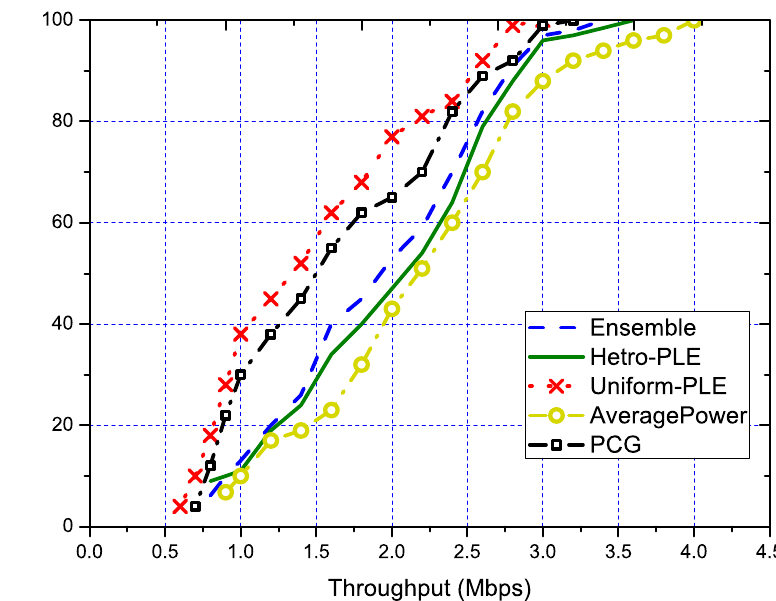
Figure 2. The CDF of throughput using different RSS estimation algorithms. PLE, Path Loss Exponent.